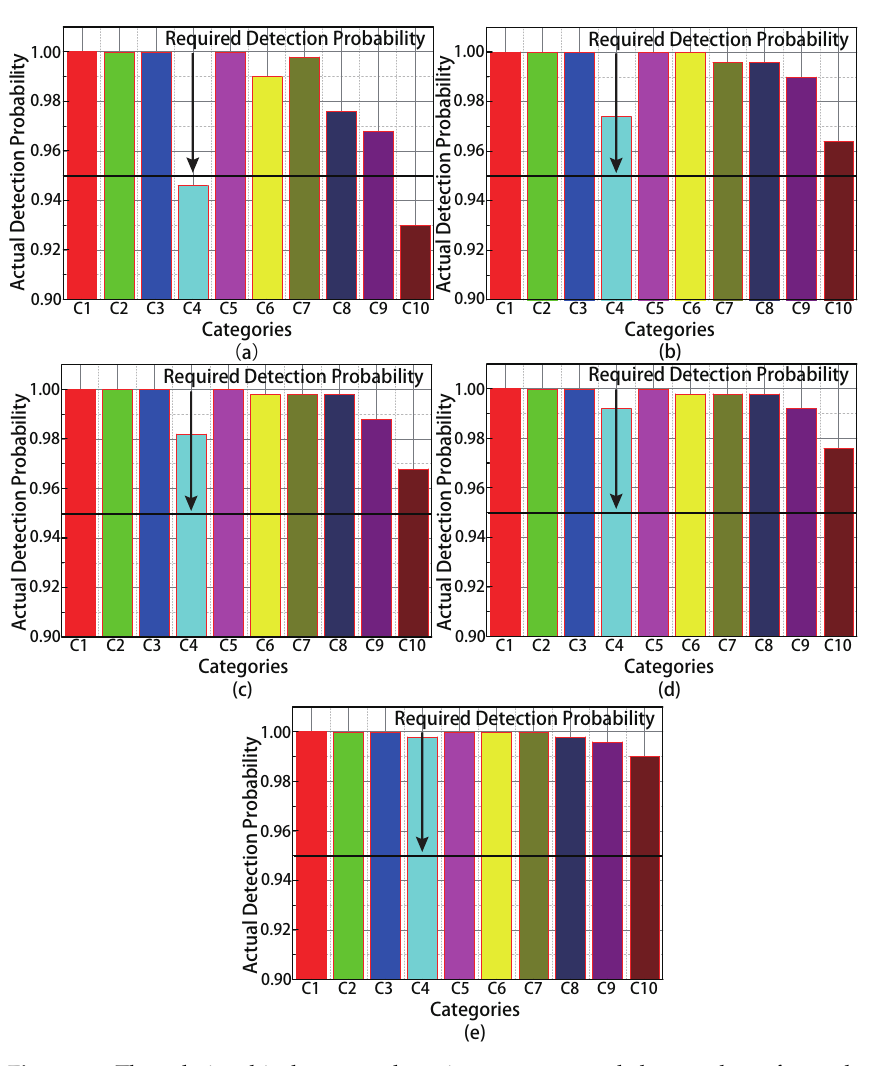
Figure 5. The relationship between detection accuracy and the number of actual missing tags.